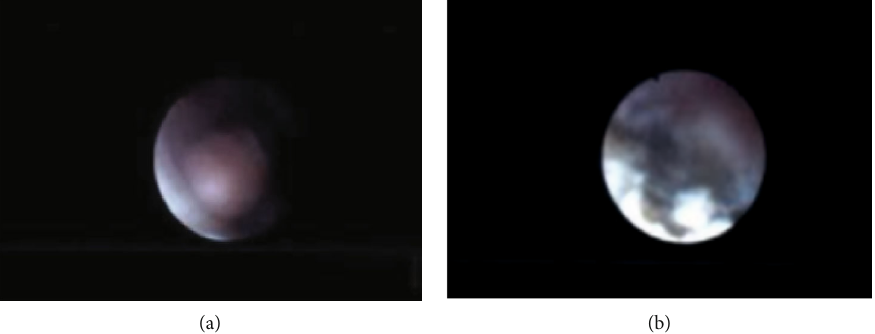
Figure 2: (a) Uteroscopic view of UTUC prior to en bloc resection. (b) Uteroscopic view of UTUC after en bloc resection. Hemostasis was achieved with no evidence of bleeding